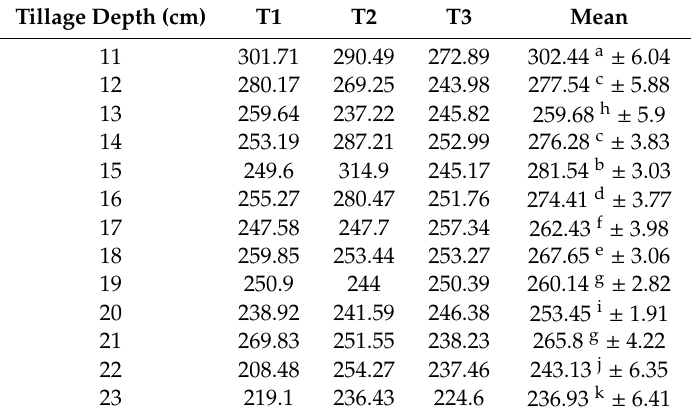
Table 8. Descriptive statistics of specific fuel consumption (g / kWh) according to tillage depth.